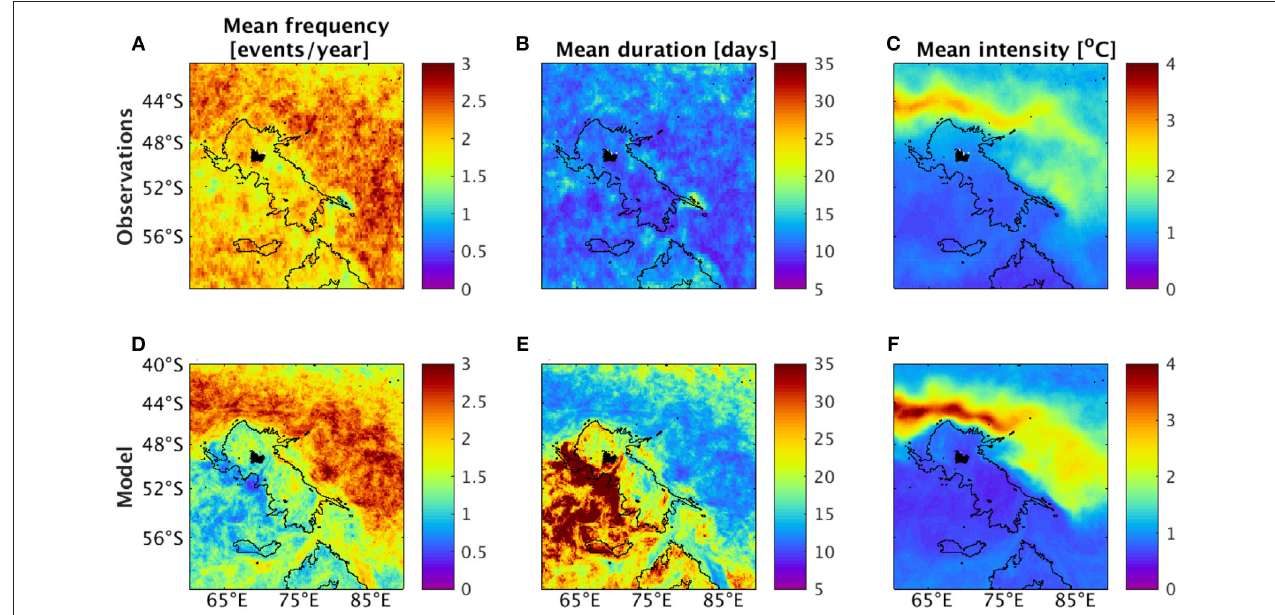
FIGURE 3 | MHW mean (A) frequency, (B) duration, and (C) intensity in NOAA-OI gridded observation-based product (1994–2016); (D–F) as in (A–C) , but for OFAM. The black line is the 3,000 m isobath.